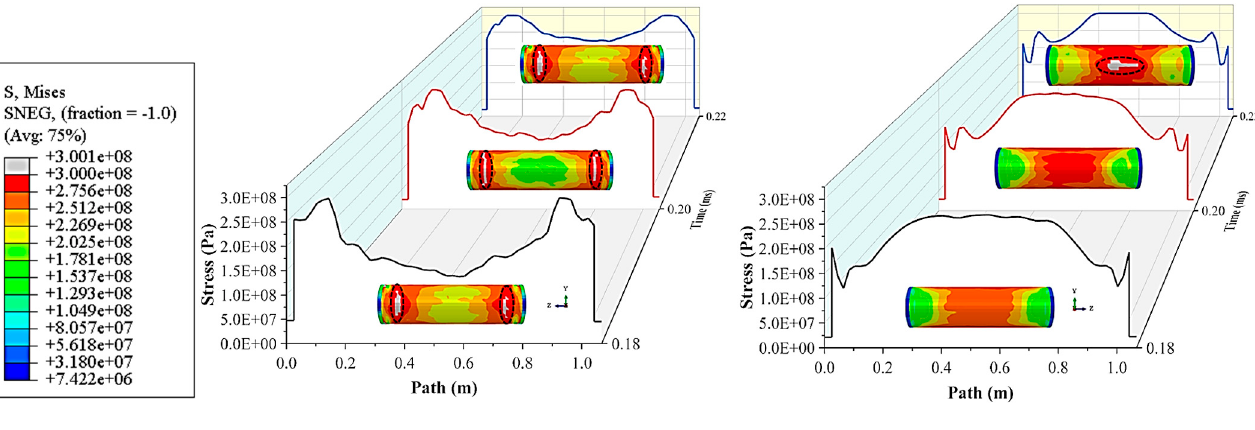
Figure 9. Stress diagram of front and rear